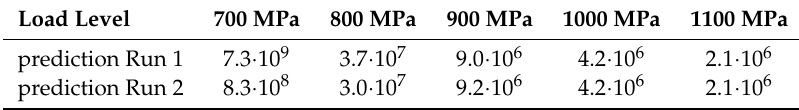
Lifetime prediction with 50% survival probability for models generated based on original